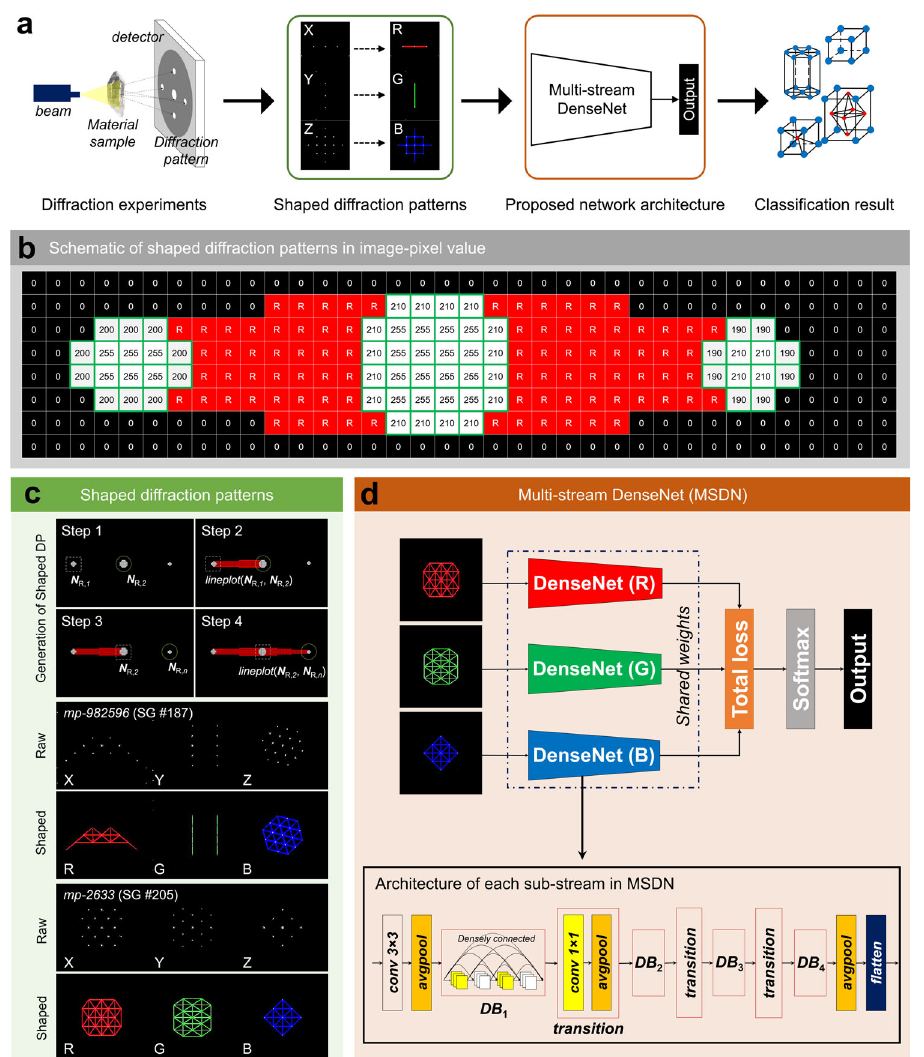
Fig. 1 Shaped diffraction patterns in an MSDN. a A scheme that describes the automated determination of crystal symmetry based on diffraction experiments. b A scheme describing the visualization of a shaped DP in image-pixel values. c A scheme describing the generation process for shaped DPs as well as two exemplary results from space groups #187 and #205. Note that in the generation scheme, the line thickness depends on the node size, which makes the shapes more unique. d The network architecture of the